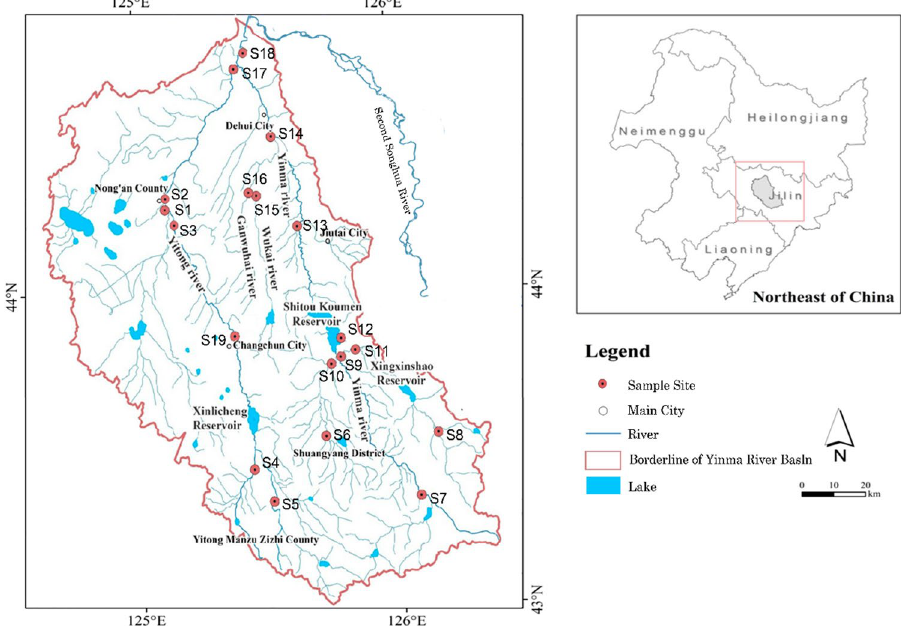
Figure 1. Study area of Yinma River and sampling sites